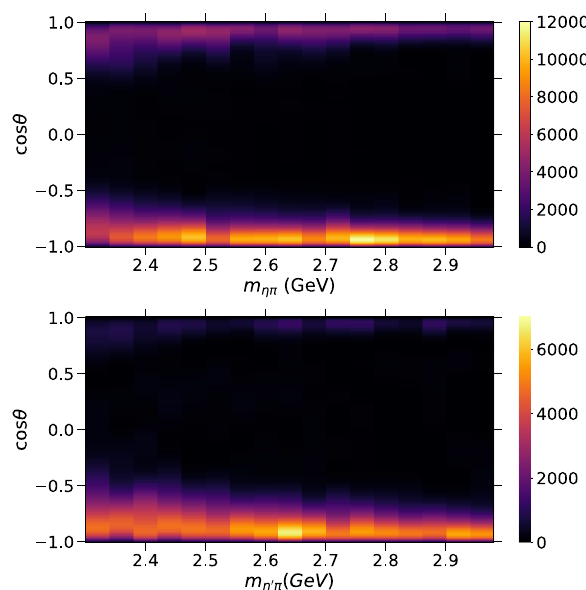
Fig. 3 Intensity I θ ( m , cos θ) density distribution of the MVR from the ηπ (upper) and η (cid:2) π (lower) COMPASS partial waves